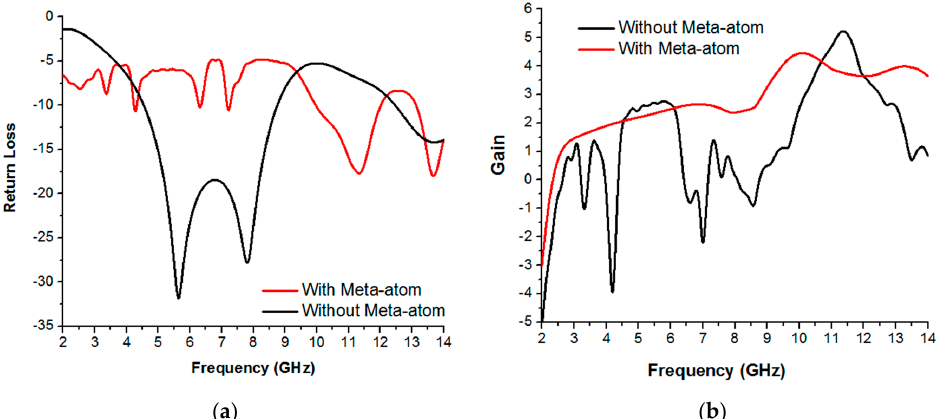
Figure 15. Antenna performances: ( a ) return loss ( S 11 ); ( b ) gain; without and with the meta-atom at the ground plane.